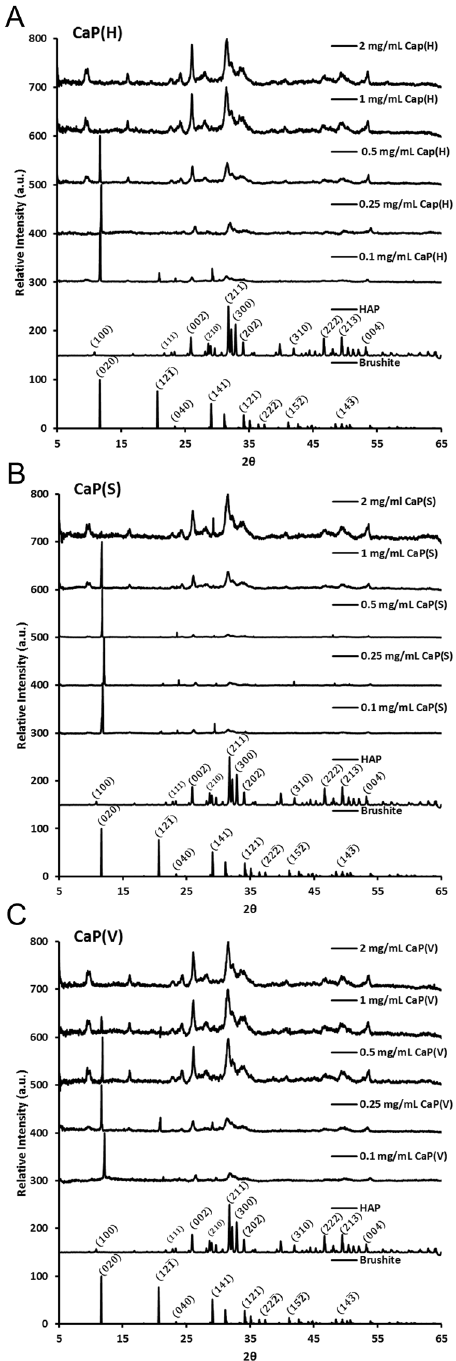
Figure 2. ( A – C ) XRD patterns of precipitates formed from reaction of 200 mM calcium chloride and 120 mM dibasic sodium phosphate in the presence of CaP(H) SVSVGMKPSPRP, CaP(S) STLPIPHEFSRE and CaP(V) VTKHLNQISQSY at initial concentrations: 0.1, 0.25, 0.5, 1 and 2